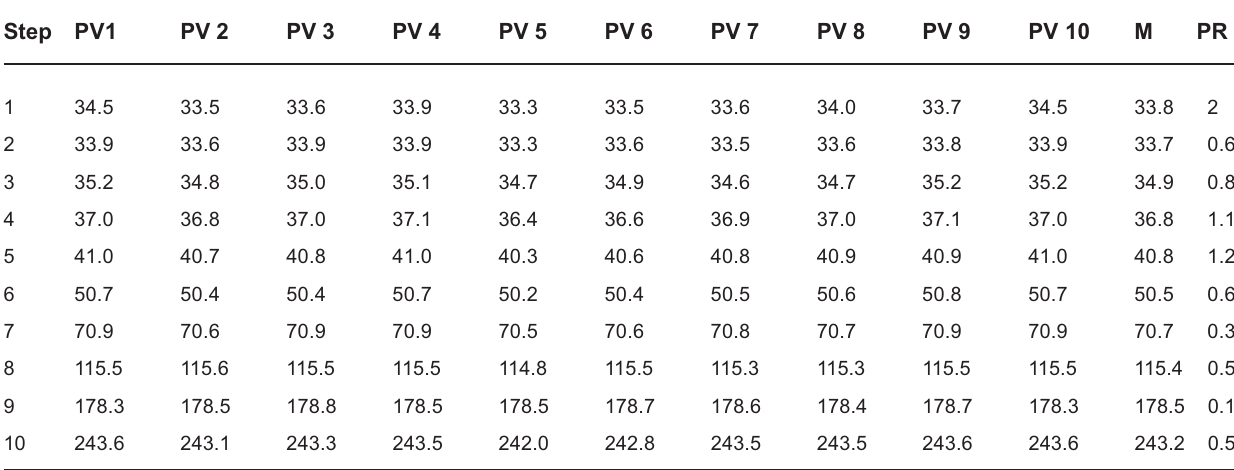
TABLE 2- Pixel values (PV1 to PV10) of each step, mean (M) and PR obtained for the HP 5370